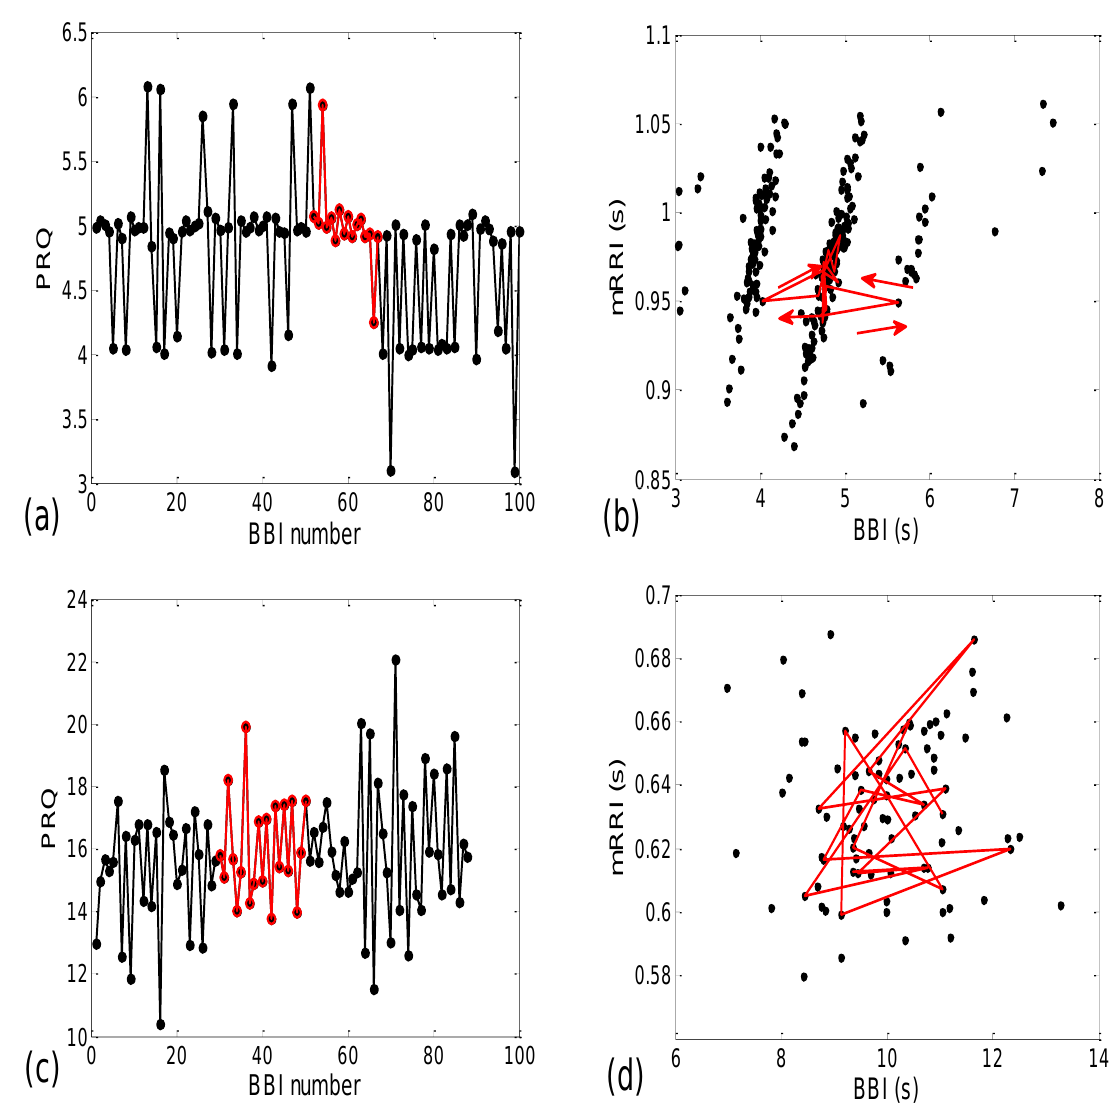
Figure 9. ( a , c ) The pulse – respiration quotient as a function of the BBI serial number (i.e., time, shown in black lines and black circles), with an arbitrarily chosen time interval colored in red; ( b , d ) the same data are presented as scatter plots of ( BBI and mRRI ) points. ( a , b ) Example of a PRQ time plot and the corresponding scatter plot, with pronounced clustering; ( c , d ) a PRQ time plot and its scatter plot, with a random distribution of points. The arrows in ( b ) indicate the directions of the point dynamics .